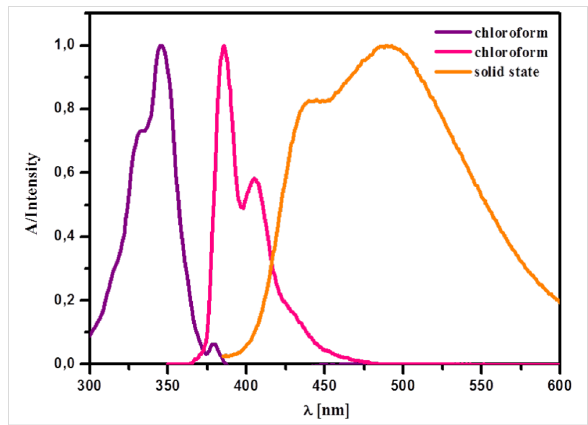
Figure 5: Normalized electronic absorption (violet) and emission (pink) spectrum of 3a in CHCl 3 ( c = 10 − 6 M) and its solid-state emission spectrum (yellow). λ excit = 360